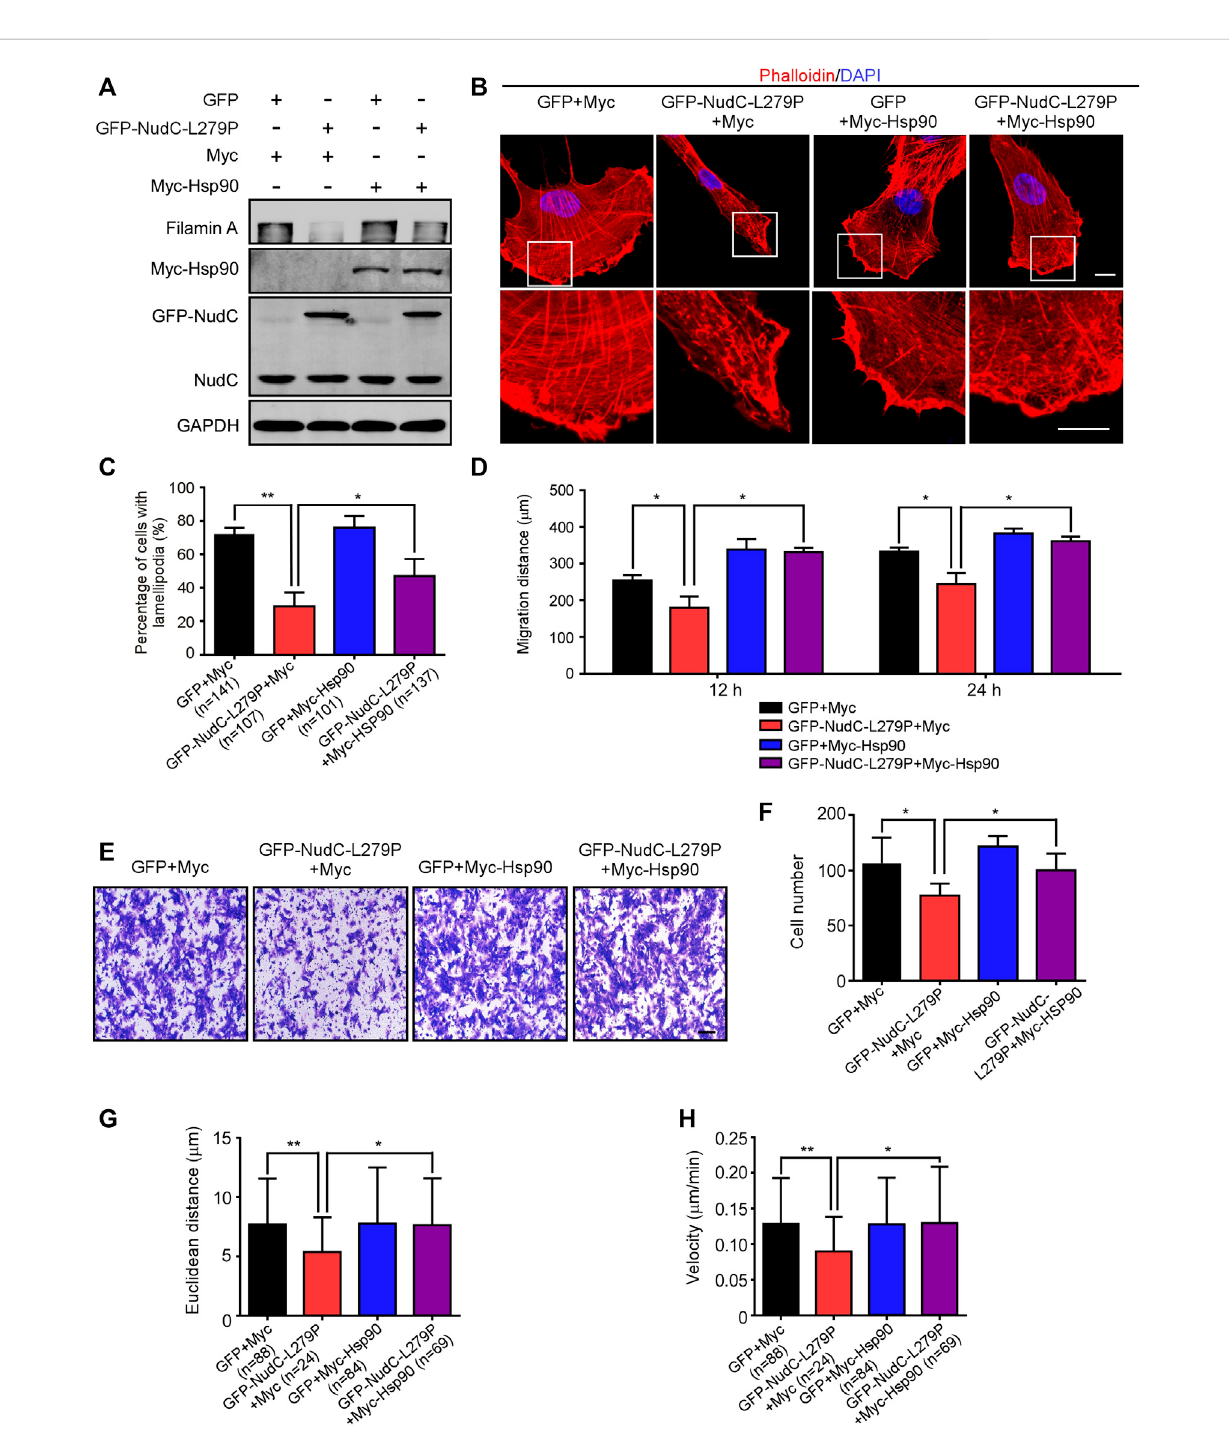
FIGURE 6 Ectopic expression of Hsp90 reverses the defects induced by NudC-L279P overexpression. RPE-1 cells stably overexpressing GFP or GFP-NudC- L279P were transfected with Myc or Myc-Hsp90 and then subjected to the following analyses. (A) Western blotting analysis of the expression of the indicated proteins. GAPDH, a loading control. (B) Cells were fi xed and stained with phalloidin. DNA was visualized with DAPI. Images were captured by immuno fl uorescence microscopy.Scalebar, 10 μ m.Higher magni fi cationsofthe boxed regions are displayed. (C) Cellswere fi xedand stained with phalloidin after 3 h of scratching. Cells with lamellipodia were counted. (D) Scratch wound assays detected cell motility. The distance of scratch closure was measured by ImageJ software. (E,F) Transwell migration assays were performed to detect cell motility. Cells that migrated to the undersides of the fi lters were stained with 0.2% crystal violet and monitored with DIC microscopy. The number of migrated cells per transwell was calculated. Scale bar, 100 μ m. (G,H) The migration tracks of individual cells were traced by Imaris 9.1.2 software. Euclidean distance and migration velocity were analyzed with Imaris 9.1.2 software. Quantitative data are presented as the means ± SD (at least three independent experiments). n , the sample size. * p < 0.05; ** p < 0.01. Student ’ s t